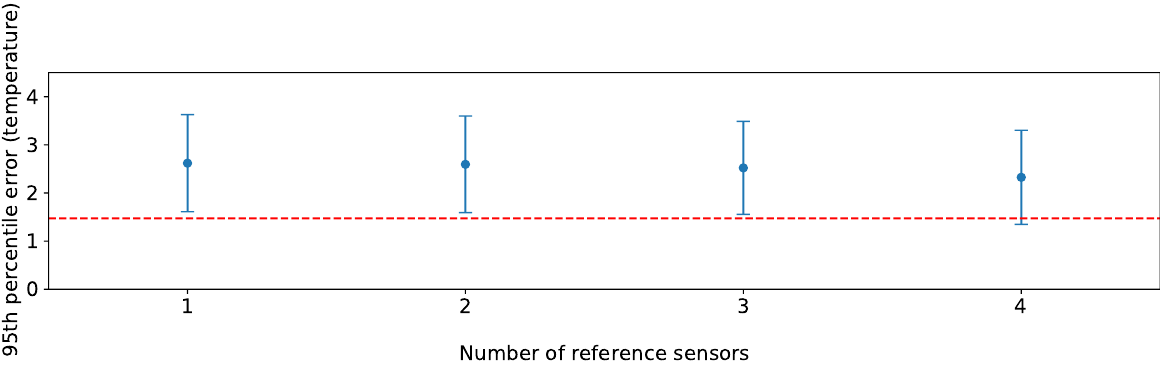
Figure 20. Results obtained from XGBoost on all possible combinations of k reference sensors, with k ∈ { 1, . . . ,4 } . For each value of k , the vertical line represents the extent of the errors given by the different combinations, while the dots represent the median error. The red dashed horizontal line represents the error obtained by the subset of reference sensors selected by our approach.